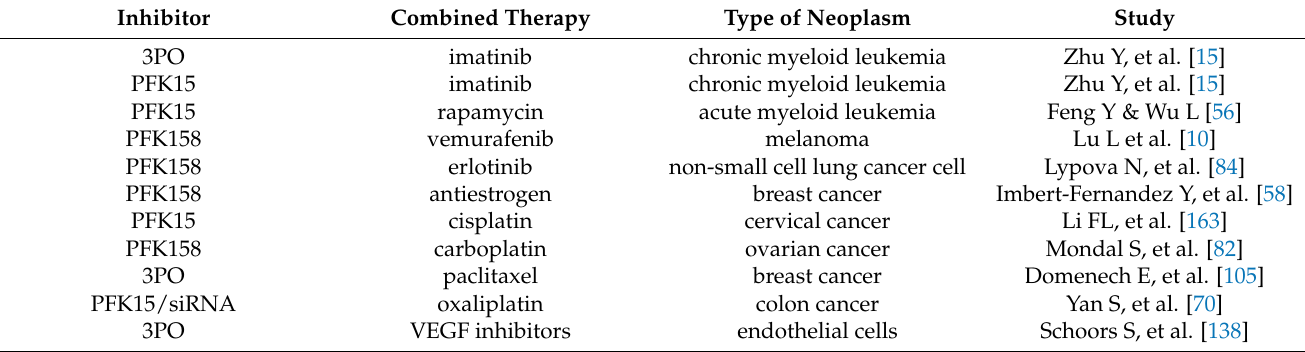
Table 2. Summary of the most relevant studies on the use of PFKFB3 inhibitors in combined therapy.